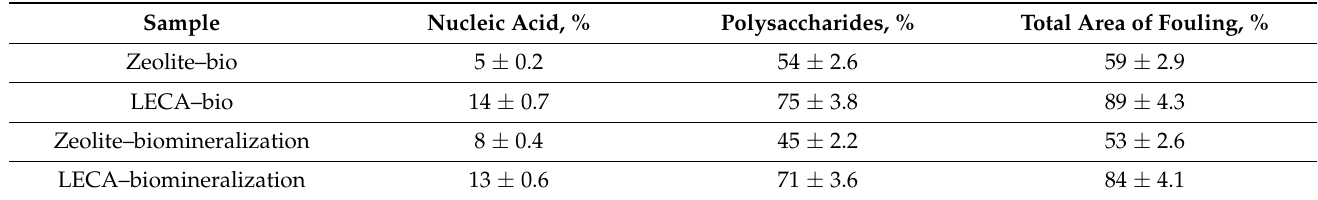
Table 3. Topological parameters of biofilm on analyzed materials (after 20 days of growth) studied by confocal scanning laser microscopy.